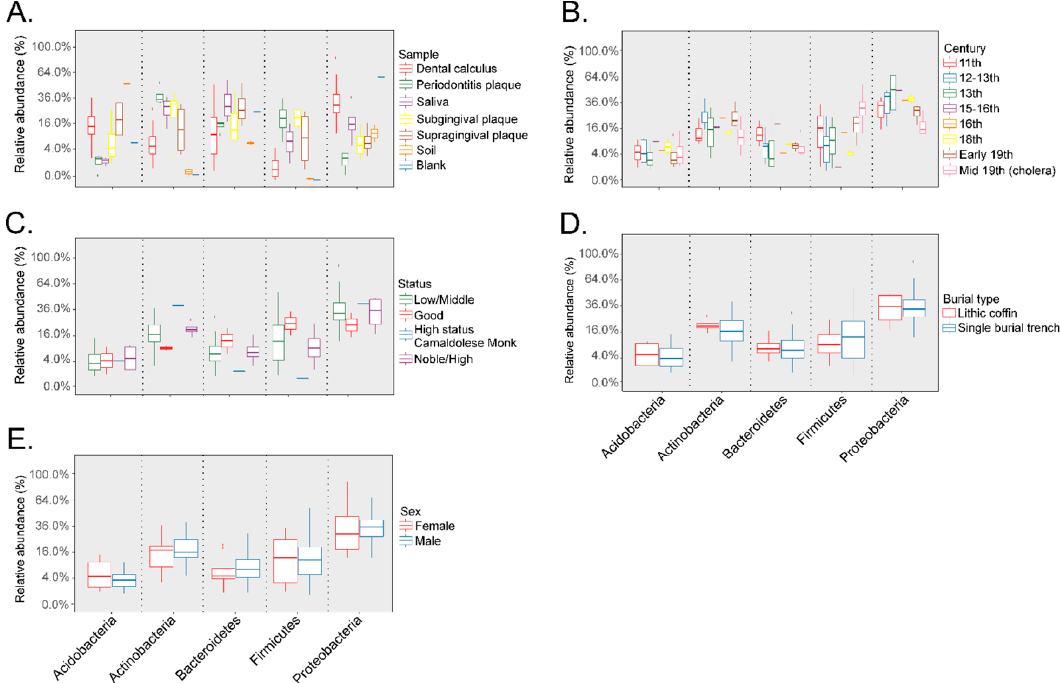
Figure 5. Relative abundances (%) of the top 5 main phyla in the dental calculus samples included Acidobacteria, Actinobacteria, Bacteroidetes, Firmicutes, and Proteobacteria. Taxonomy analyses were performed based on sample type ( Panel A ), century ( Panel B ), social status ( Panel C ), burial type ( Panel D ), and gender ( Panel E ).